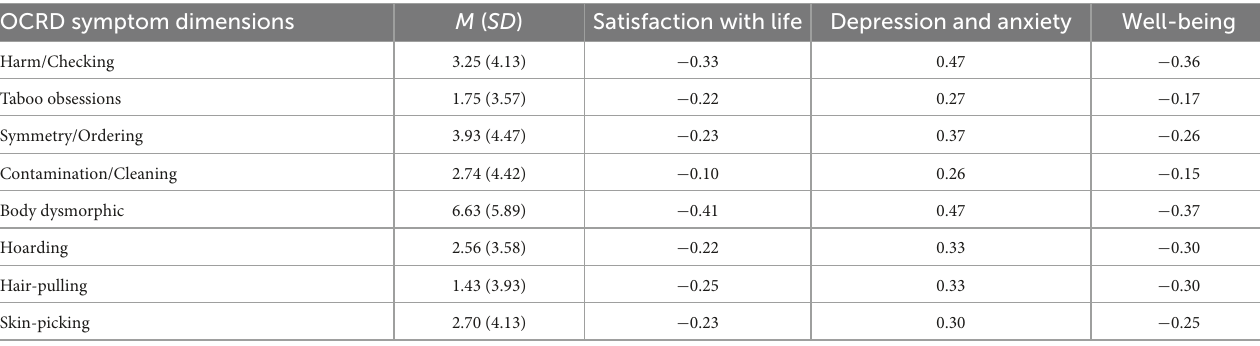
TABLE 2 Means and standard deviations for all OCRD-D-E scales and correlations with satisfaction with life, depression/anxiety symptoms, and well-being. OCRD symptom dimensions M ( SD ) Satisfaction with life Depression and anxiety